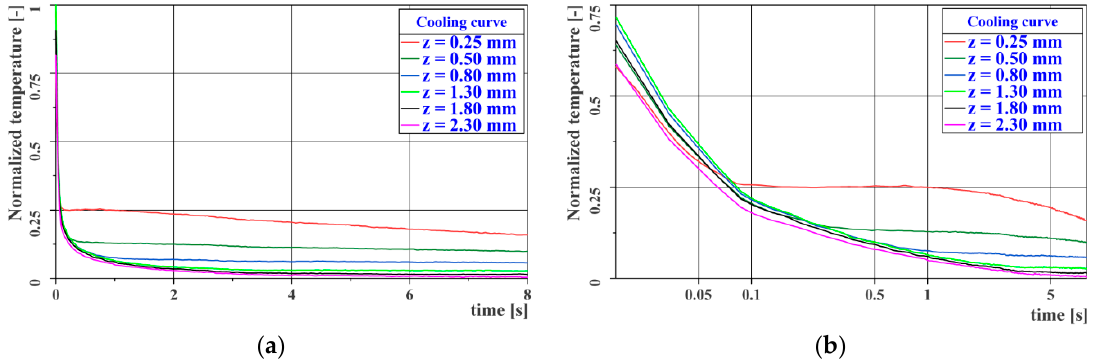
Figure 11. Cooling curves for the reference gauge: ( a ) linear time axis; ( b ) logarithmic time axis.